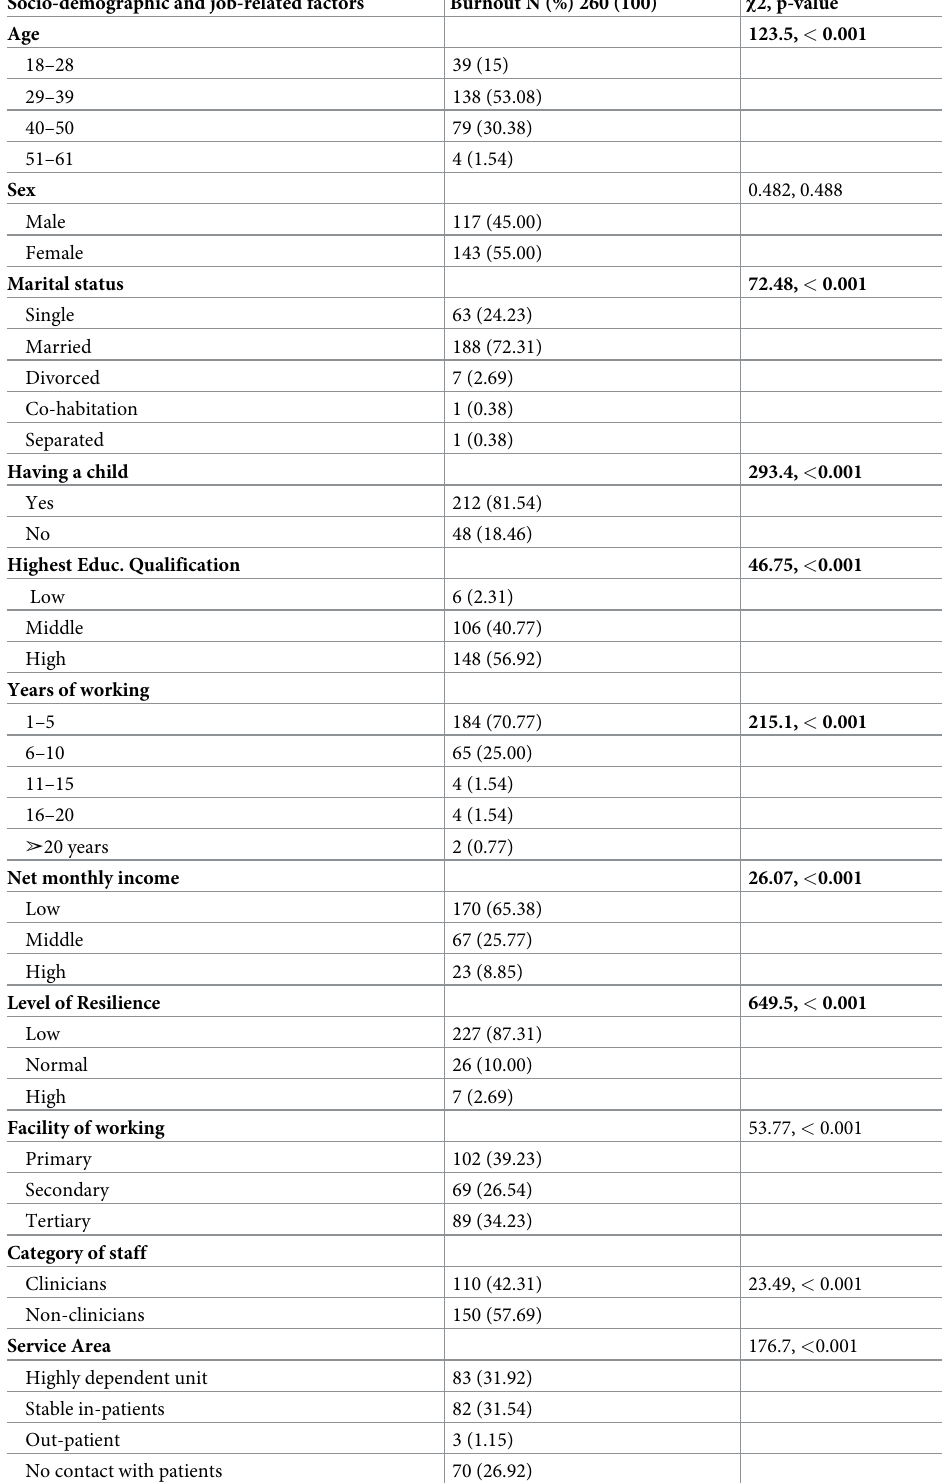
Table 4. Bivariate analysis of burnout and socio-demographic and job-related factors. Socio-demographic and job-related